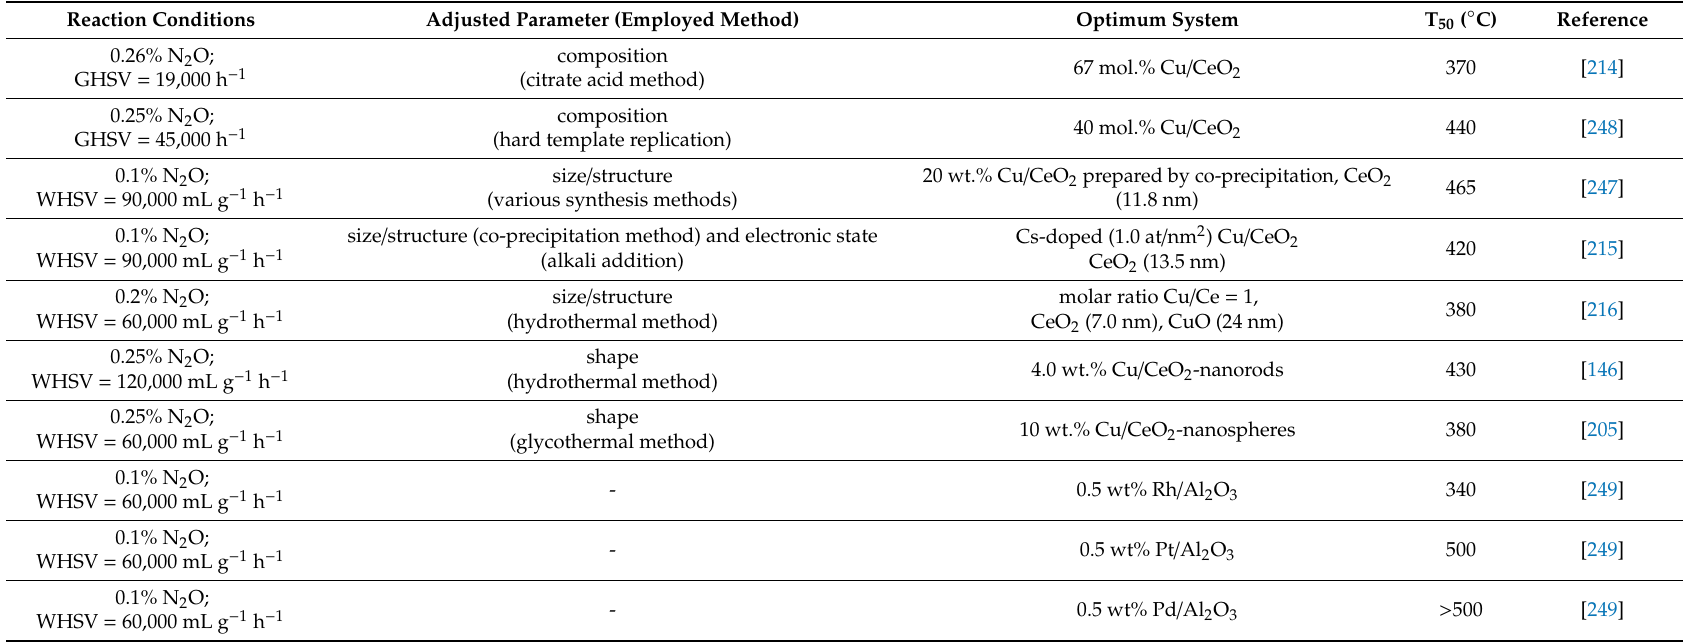
Table 2. Indicative studies followed to adjust the deN 2 O performance of CuO x / CeO 2